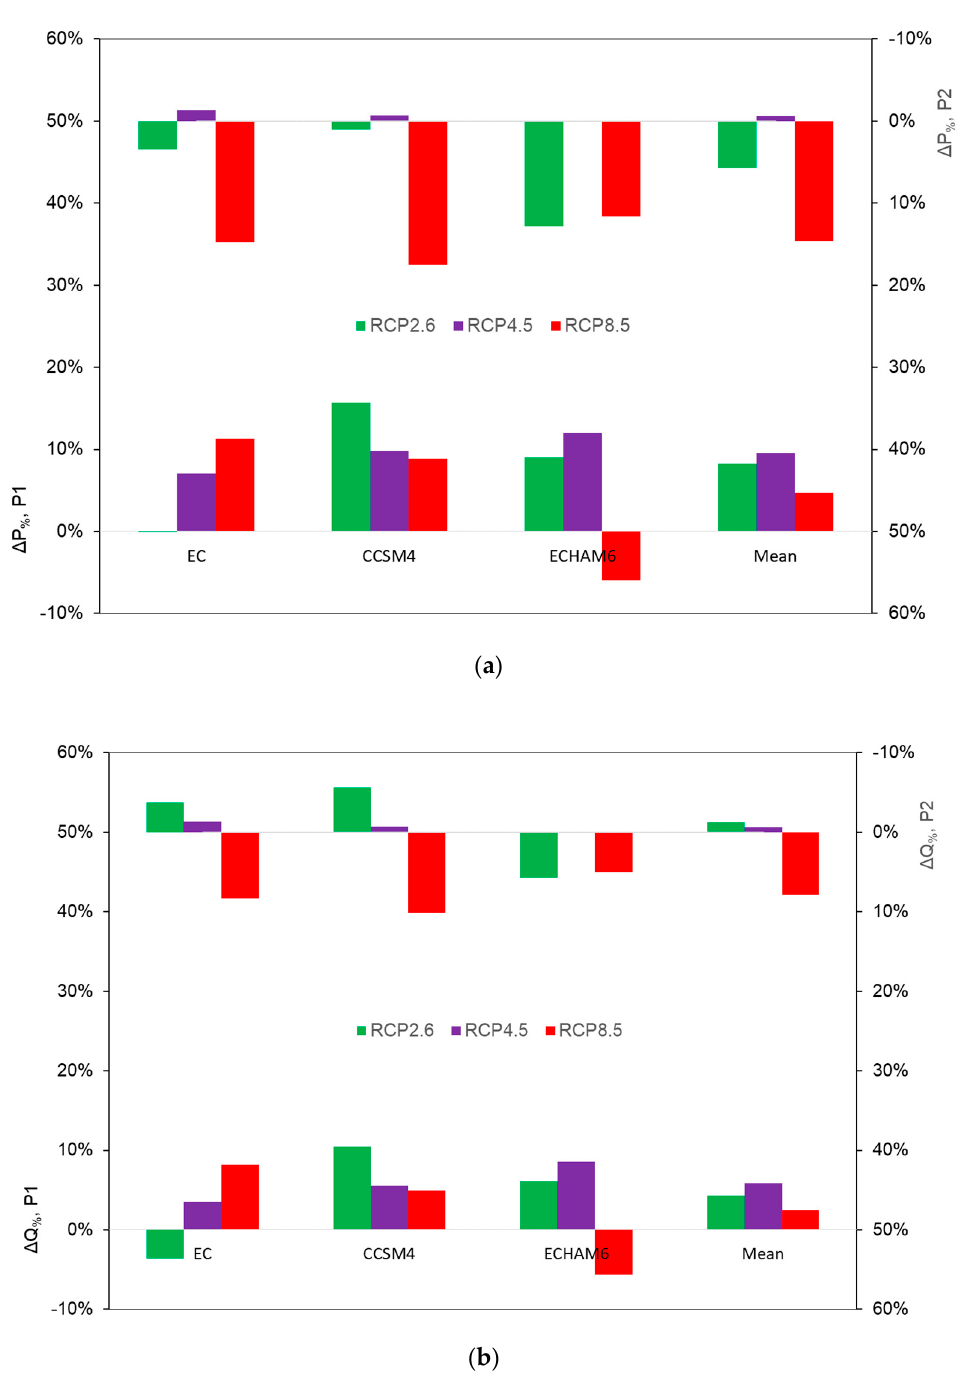
Figure 7. Rabuwa Bazar. Mean annual variations (in percentage) for the decades P1 , 2041–2050 (left y axis), and P2 2091–2100 (right y axis, values upside down), against CR period (2004–2013). ( a ) Precipitation. ( b ) Streamflows.